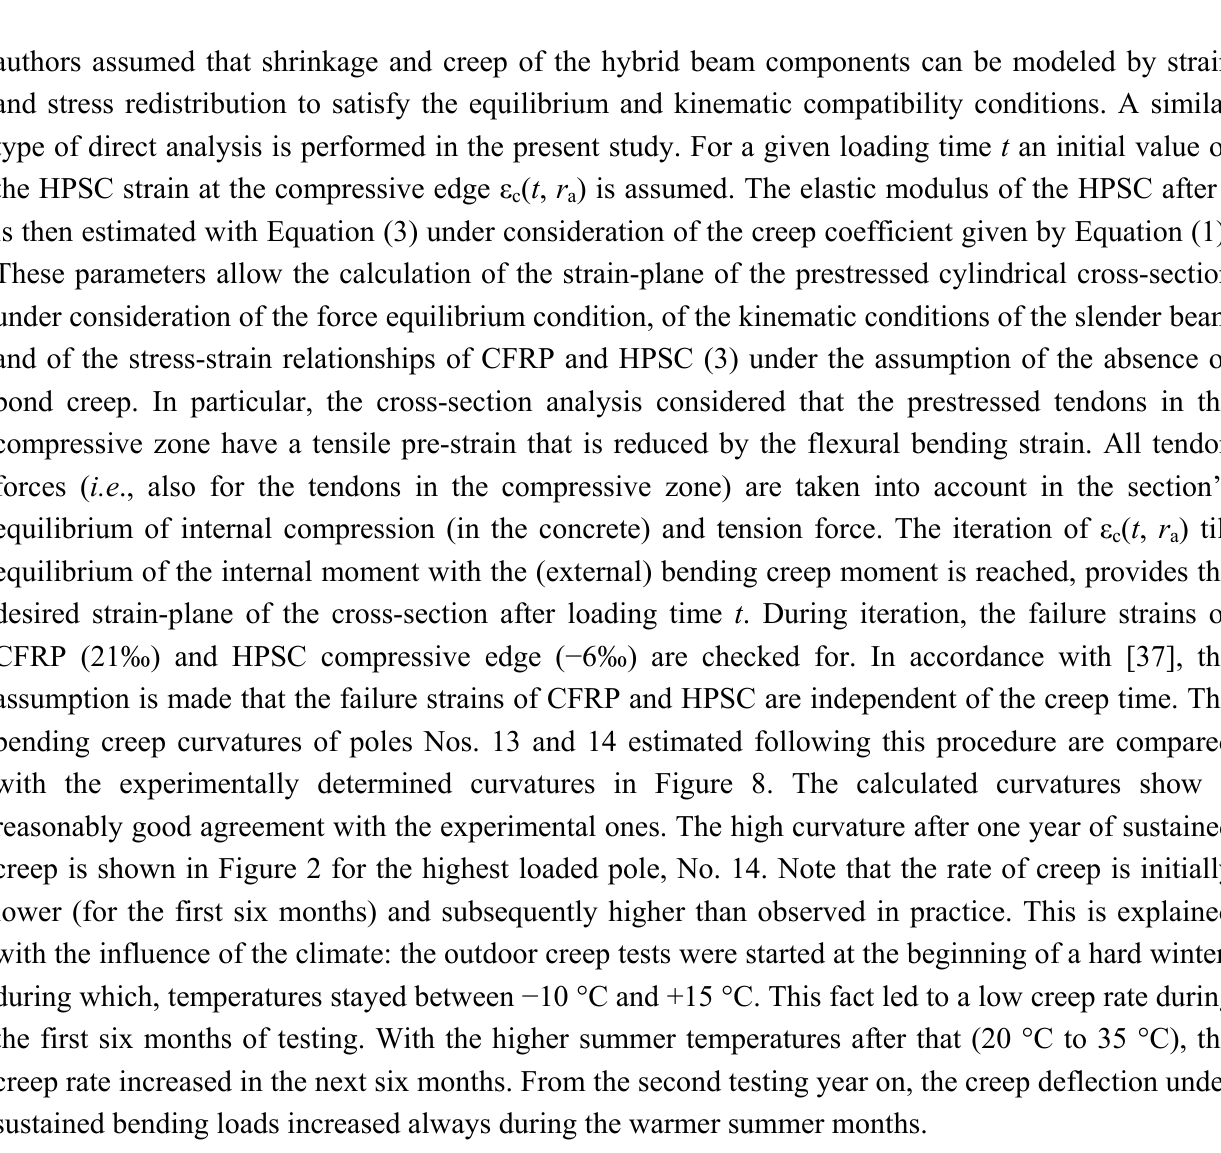
Figure 8. Bending creep curvatures vs. time for pole Nos. 12–14 (16.5 years of